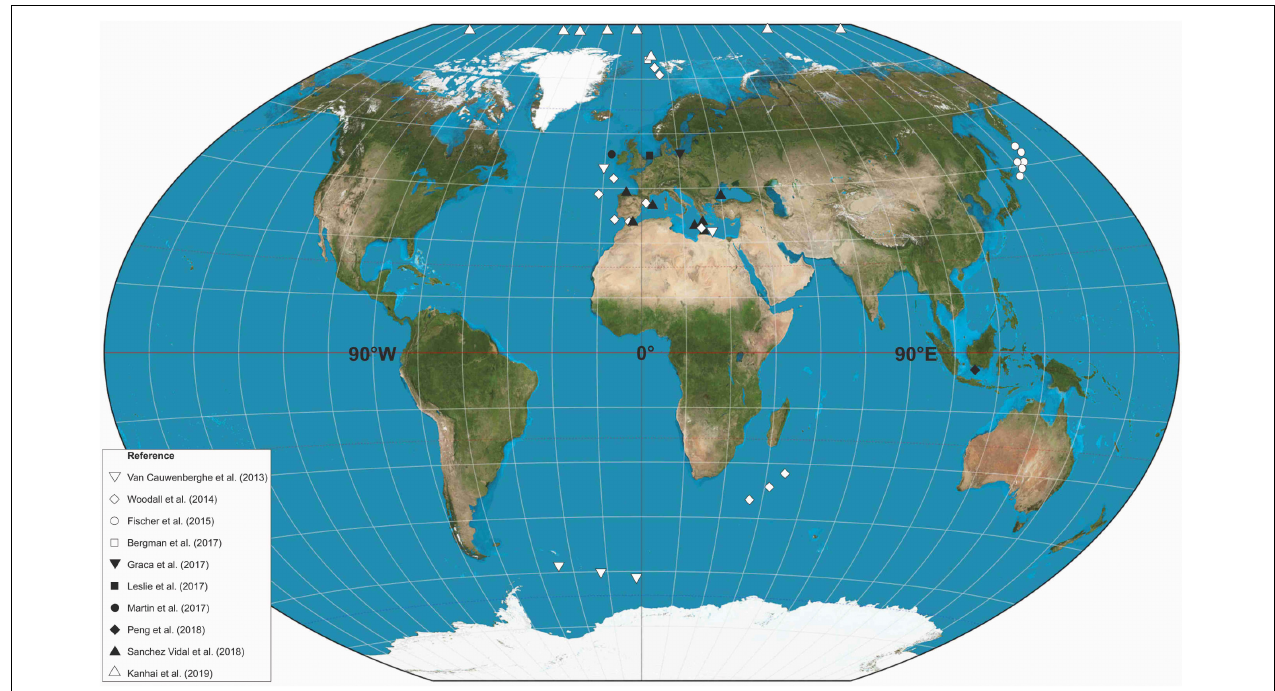
FIGURE 2 | Global distribution of studies which have identified microplastics in deep-marine sediment samples. Positions marked are approximate.